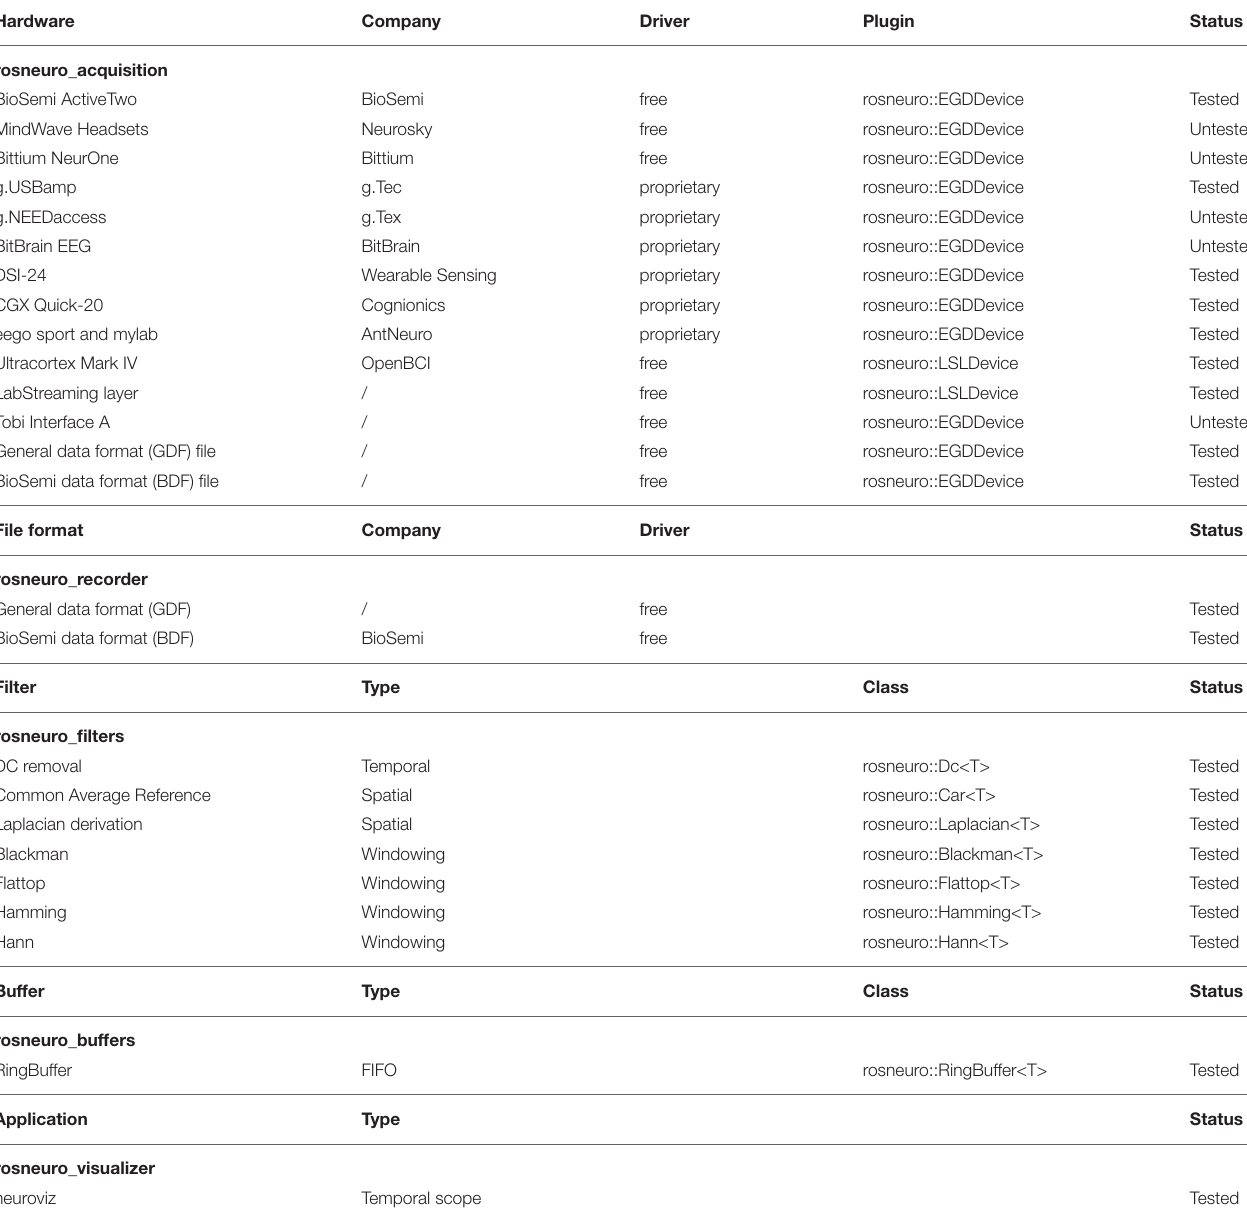
TABLE 1 | List of acquisition devices and platforms currently compatible with the rosneuro_acquisition package and the file formats supported by the rosneuro_recorder